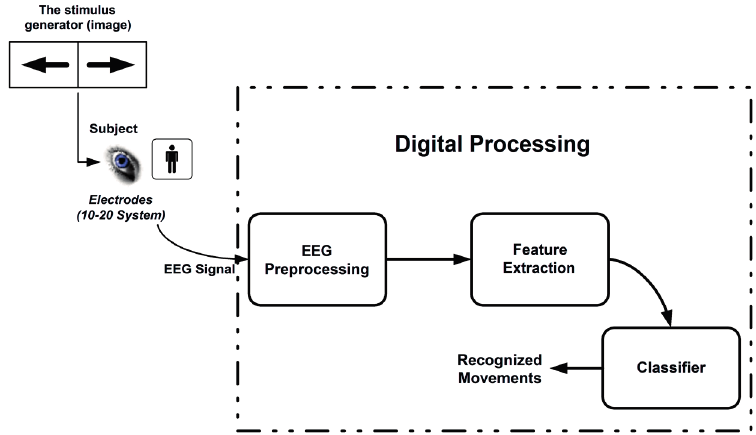
Figure 1. A typical system block